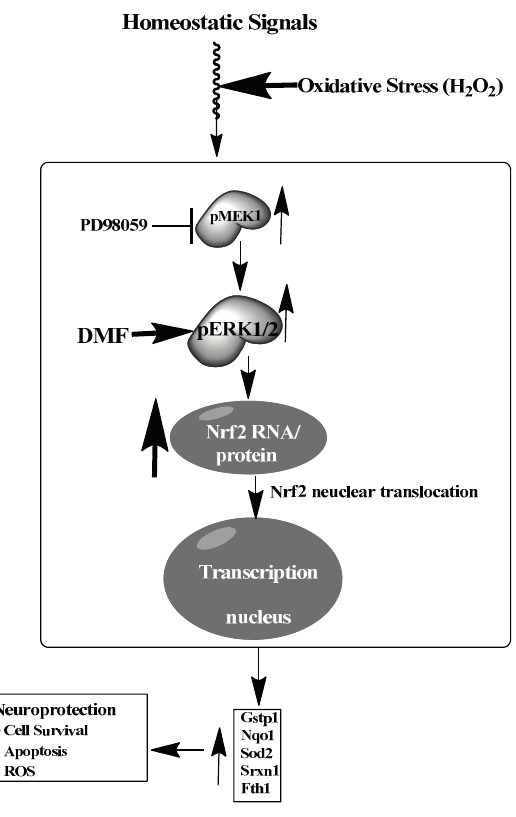
Figure 7. Schematic model of DMF-induced neuroprotection in rat NPCs and differentiated neurons. Under oxidative stress (H 2 O 2 ), DMF enhances Nrf2-mediated antioxidant response gene transcription through activation of ERK1/2 MAPK signaling pathway leading to neuroprotection in rNPCs and differentiated